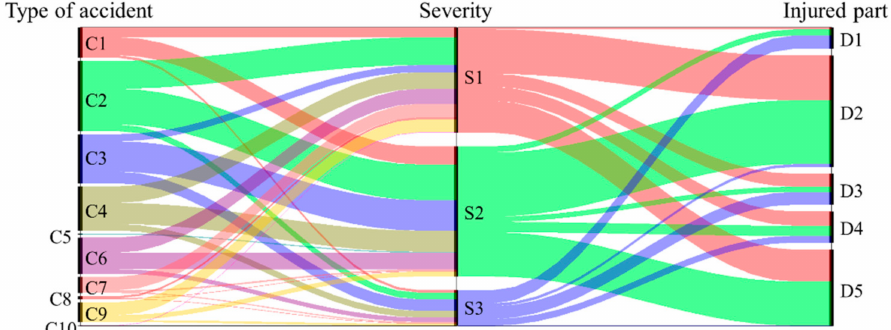
Figure 6. Alluvial flow diagram using variables with large correlations for predicting injured